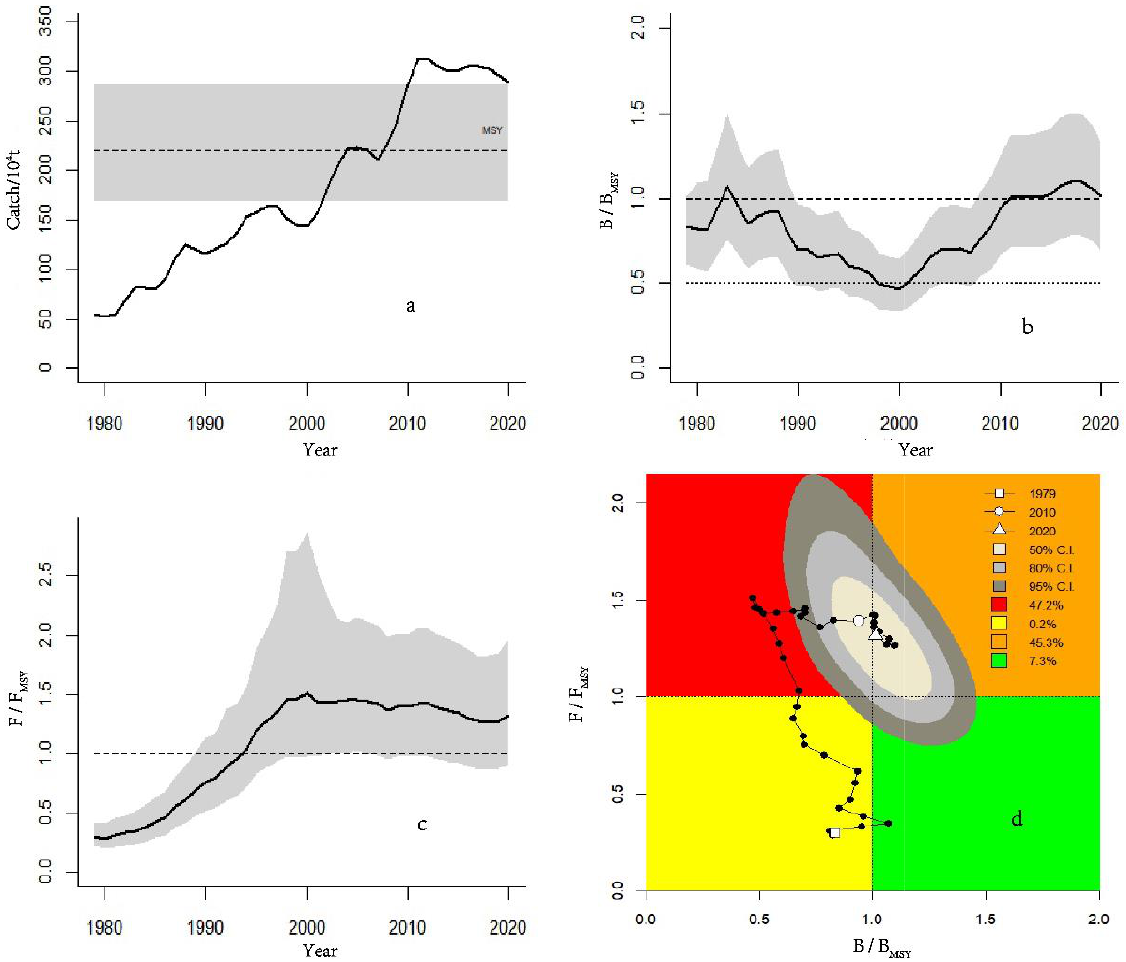
Figure 3. Results of stock assessment for Mackerel_ECS from BSM where ( a ) is the production, the horizontal broken line is the estimated value of MSY, and the grey region is the 95% confidence interval; ( b ) is the relative total biomass (B/B MSY ), the broken line of level 1 is the maximum sustainable biomass B MSY giving MSY, the dotted line of level 0.5 is 0.5B MSY , and the grey area is uncertainty; ( c ) is relative fishing pressure (F/F MSY ); and ( d ) is a Kobe plot between relative population biomass (B/B MSY ) and relative exploitation rate (F/F MSY ). The shaded areas are 50%, 80% and 95% confidence intervals (C.I.).